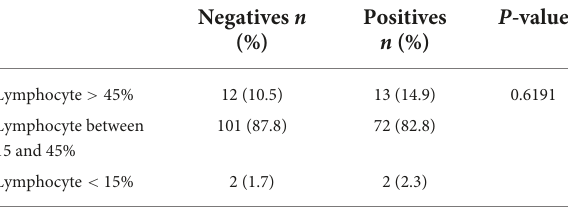
TABLE 6 Analysis of the frequency of the study population in relation to the absence or presence of atypical lymphocytes. Absence of atypical